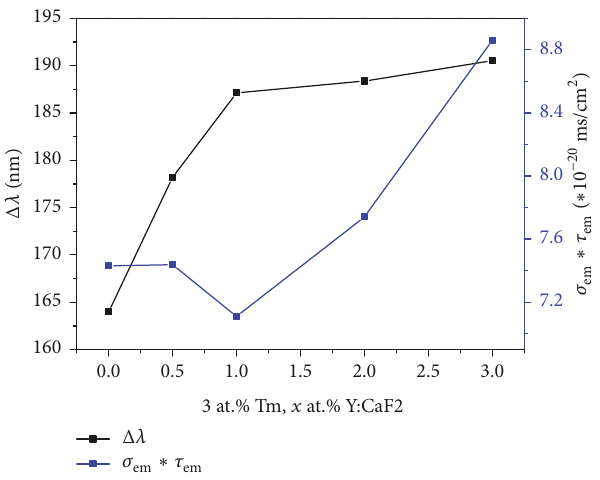
Figure 5: 𝜏 rad ∗𝜎 em and Δ𝜆 obtained from 3 at.% Tm, 𝑥 at.% Y:CaF 2